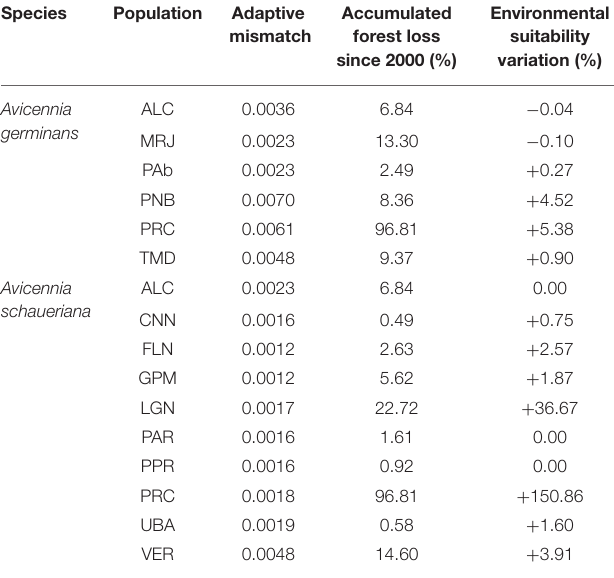
TABLE 3 | Summarized variations in present and future (2100, RCP85/SSP-85) adaptive allelic frequencies (Procrustes differences between present and future scenarios), accumulated forest loss since 2000 (%) based on current local deforestation rates, and suitability differences based on ensemble presence-absence species distribution models